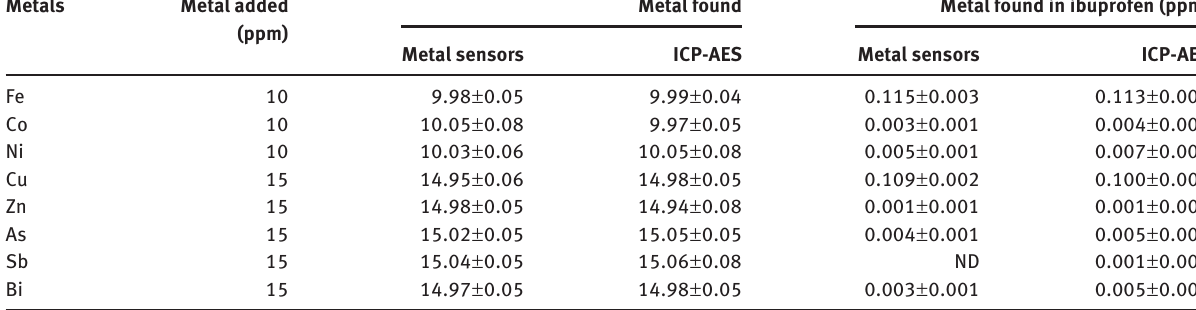
Table 5 Analytical data for